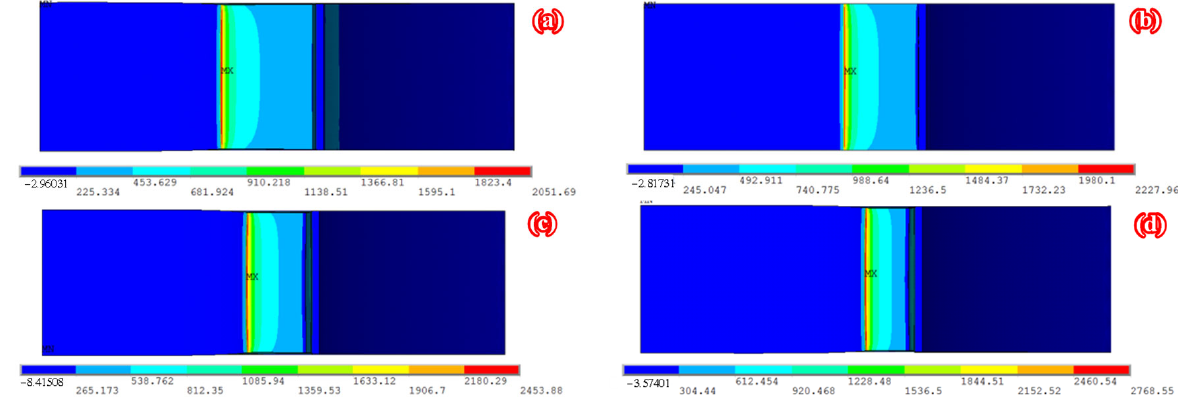
 Figure 11. Distribution characteristics of SIF along the crack front of the semi ‐ elliptical surface crack of specimen C9 ‐ DS1 ‐ A during partial ‐ through crack propagation stage. Figure 12 shows the distribution of tensile stress along the crack front of specimen C9 ‐ DS1 ‐ A during the through crack propagation stage. As shown in Figure 12, the tensile stress at each point along the crack front increases continuously with the continuous crack propagation; moreover, the tensile stress is symmetrically distributed along the thickness direction of the steel plate and the maximum tensile stress is in the middle of the plate thickness. Figure 13 depicts the distribution characteristic of the SIF at the crack front along the thickness direction during the though crack propagation stage. It can be found from Figure 13 that the SIF values at the crack front are symmetrically distributed along the thickness direction of the steel plate. The K ‐ value at the crack front in the middle of the steel plate thickness is greater than that at the surface of the steel plate, which means that the crack propagation rate in the middle of the steel plate thickness is greater than